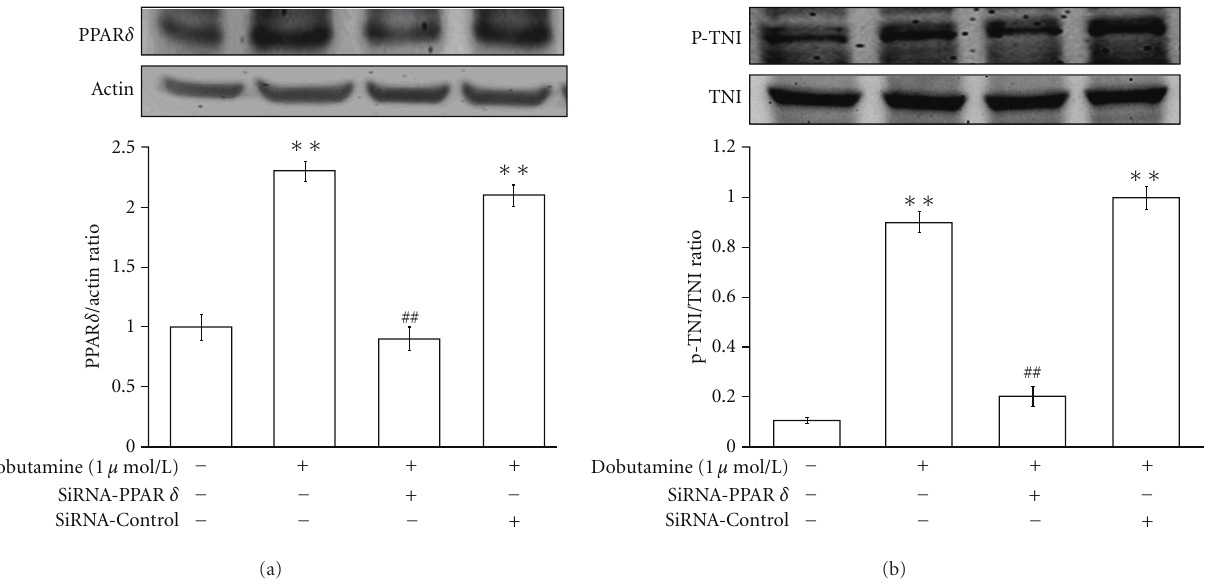
Figure 4: E ff ects of PPAR δ -targeted siRNA on dobutamine-induced actions in neonatal rat cardiomyocytes . The neonatal rat cardiomyocytes transfected with siRNA-targeted to PPAR δ or siRNA-scramble (siRNA-control) were incubated with 1 μ mol/L dobutamine. All cells were then harvested to measure PPAR δ expression (a) or cTnI phosphorylation (b) using Western blotting analysis. All values are expressed as mean ± SEM ( n = 6 per group). ∗ P < 0 . 05 as compared with the vehicle-treated control and # P < 0 . 05 as compared with the dobutamine- treated cells transfected with the scramble siRNA